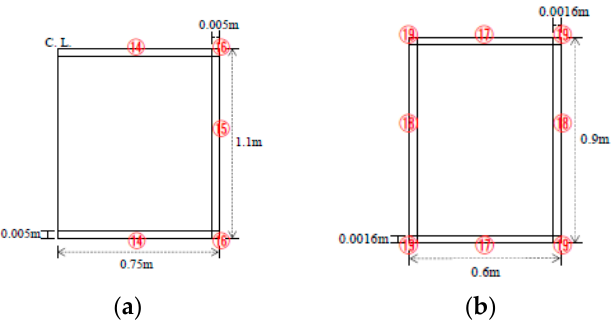
30 of 33 Figure A1. Distortion increasing rate.